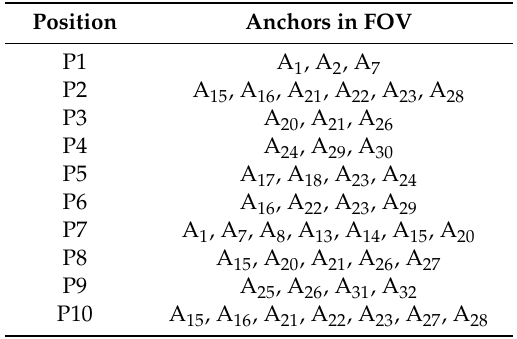
Table 5. Measurable anchors from P1 to P10.